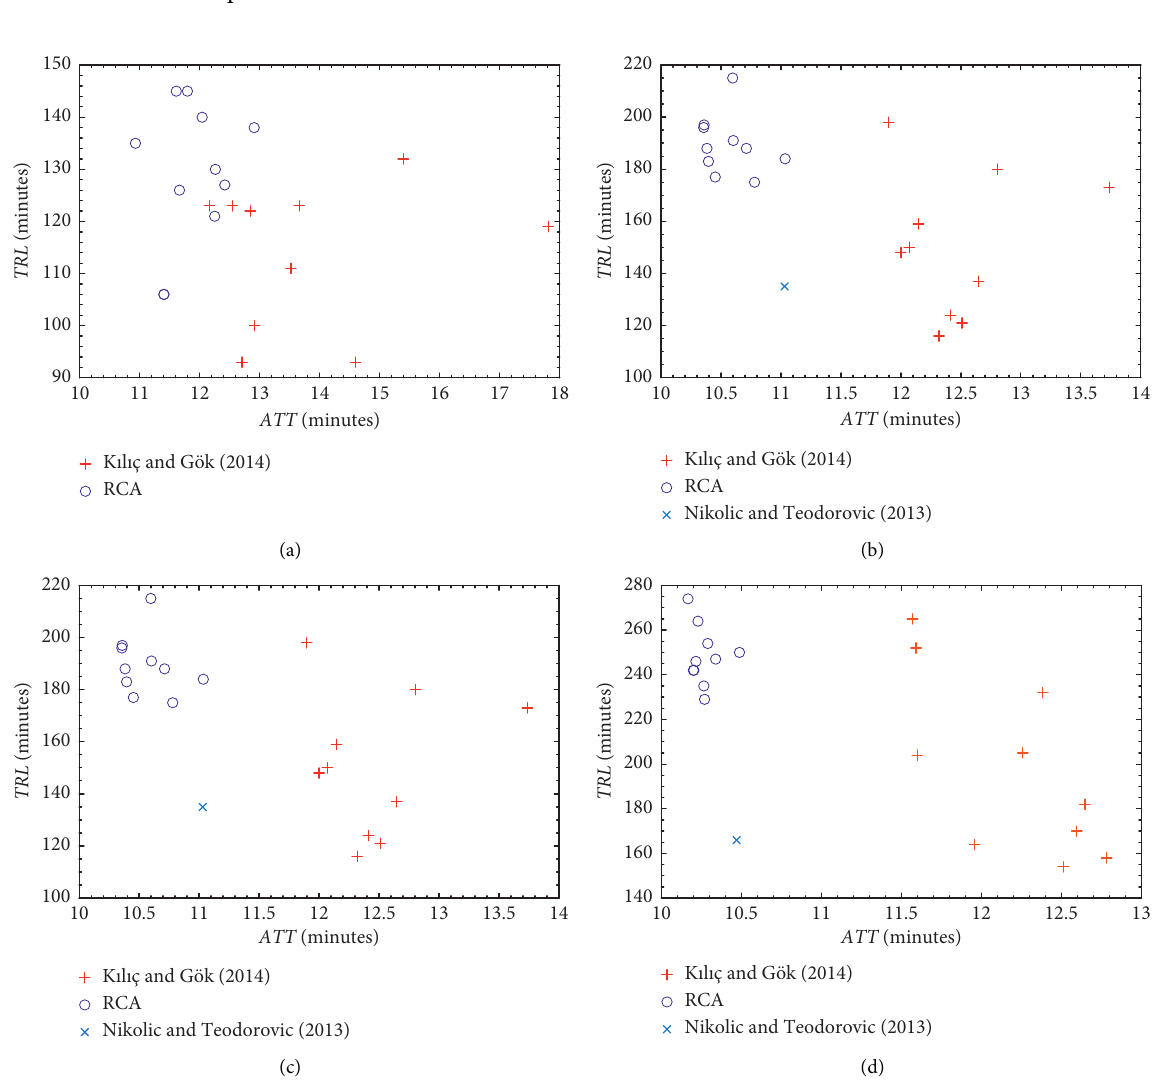
Figure 6: Comparisons of the initial solutions for Mandl’s network. (a) | R | � 4. (b) | R | � 6. (c) | R | � 7. (d) | R | �